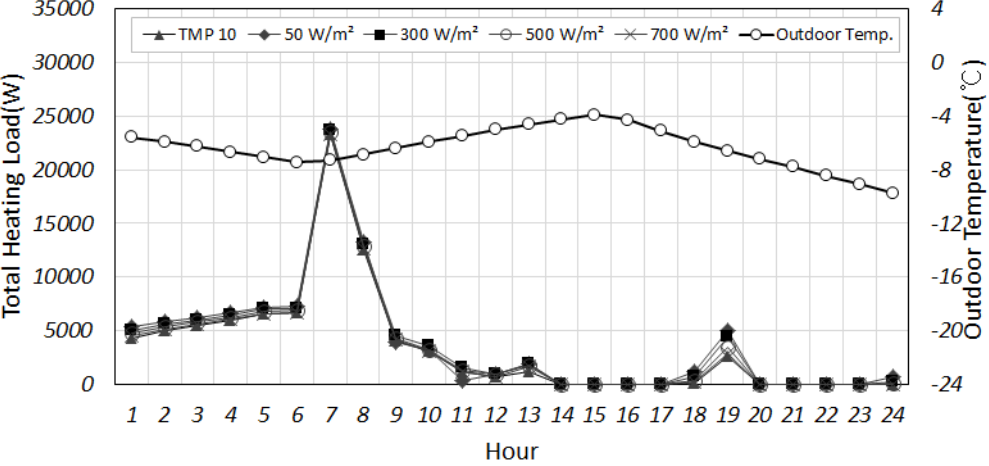
Figure 10. Heating load of electrochromic glass on a typical winter day by controlling conditions.